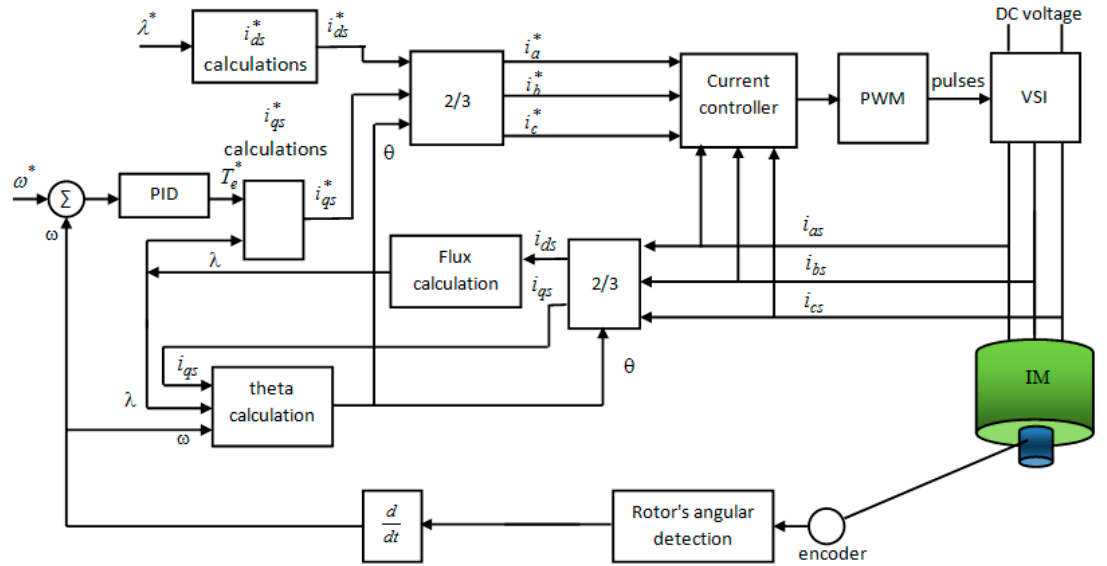
Figure 8. Block diagram of the IM controlled via vector control.